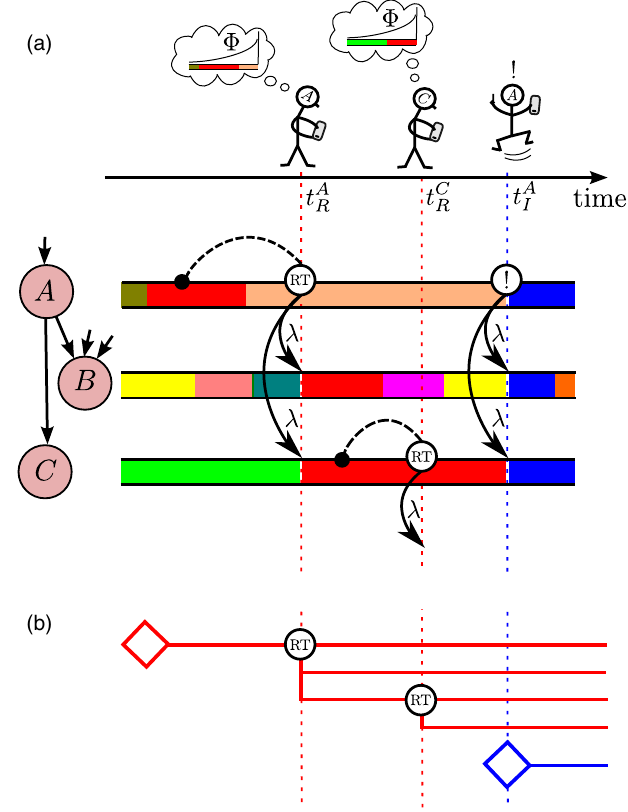
FIG. 1. Schematic of the model. (a) Timeline of users ’ actions in a typical realization of the model. User A is followed by users B and C ; arrows between nodes denote the direction of informa- tion transmission. Note that user B also follows many other users, and so his stream contains more memes than the streams of A or C . At time t A , user A retweets a previously seen meme (with R probability 1 − μ , given A is active). She chooses the red meme to retweet, by looking backwards in her stream a distance deter- mined by the memory-time distribution Φ (only memes that A deemed “ interesting ” are shown in her stream). Her retweet of the red meme is accepted as interesting (and so inserted into their stream) by each follower of A with probability λ . At time t C , user R C retweets the red meme to his followers, thus further increasing the popularity of the red meme. At time t A , user A innovates (a I probability μ event, given A is active) by inventing the new blue meme and broadcasting it to her followers. (b) Branching process representation (Sec. III) of the popularities of the red meme and of the blue meme. Each retweet generates new branches of the process, as the meme is inserted into the streams of followers of the tweeting